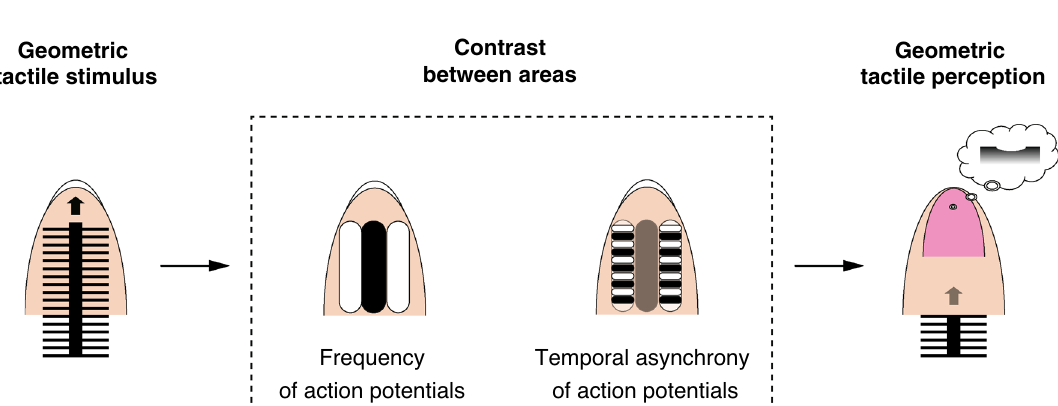
Figure 6. Calculated incoherency of mechanical displacements through pin matrices. The temporal incoherency of ( a ) height and ( b ) height change was indexed by the Shannon entropy. ( c ) Relationship between incoherency of tactile stimuli through pin matrices and temporal asynchrony of action potentials for different pin matrix conditions.